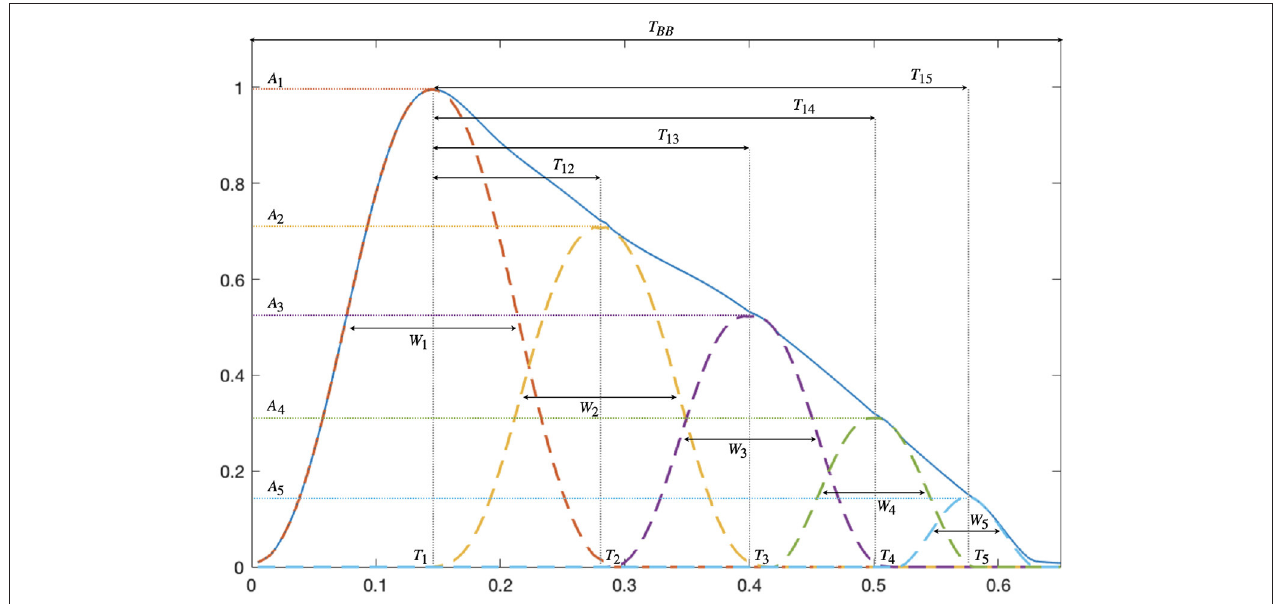
FIGURE 1 | PPG pulse waveform features derived from the amplitude A j , position T j , and width W j of the K = 5 decomposed